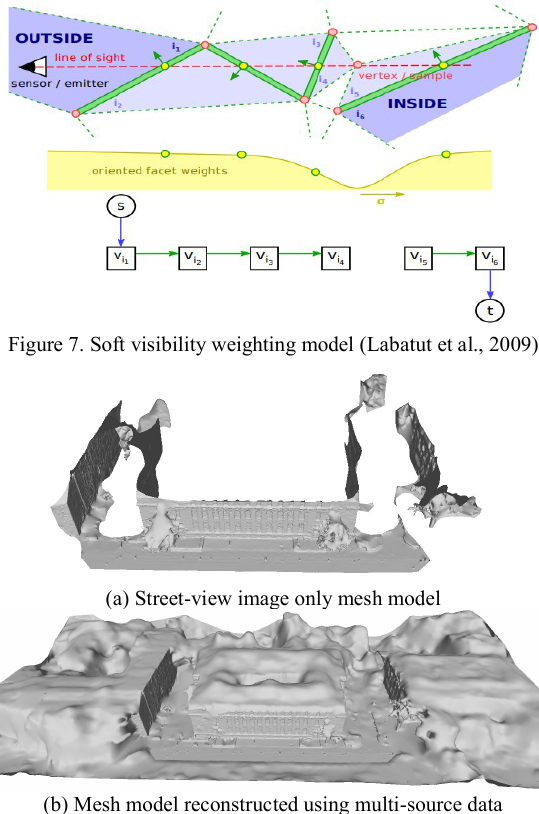
(b) Mesh model reconstructed using multi-source data Figure 8. Reconstructed surface model using only the street-